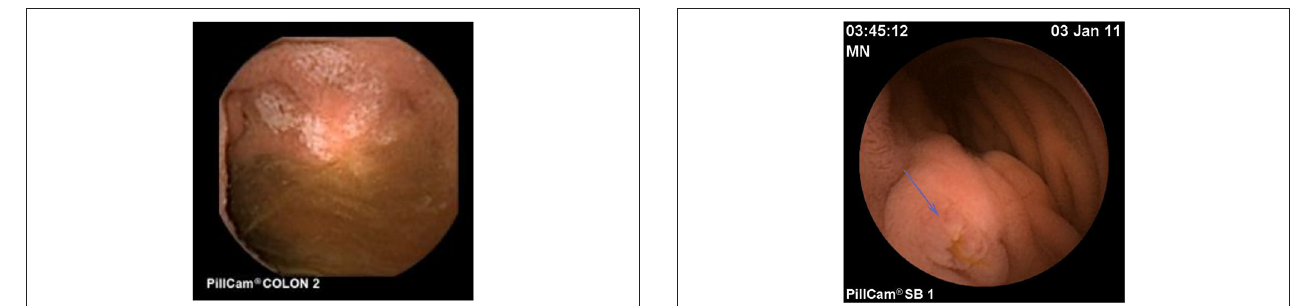
FIGURE 10 | Lymphangiectasia (patchy).